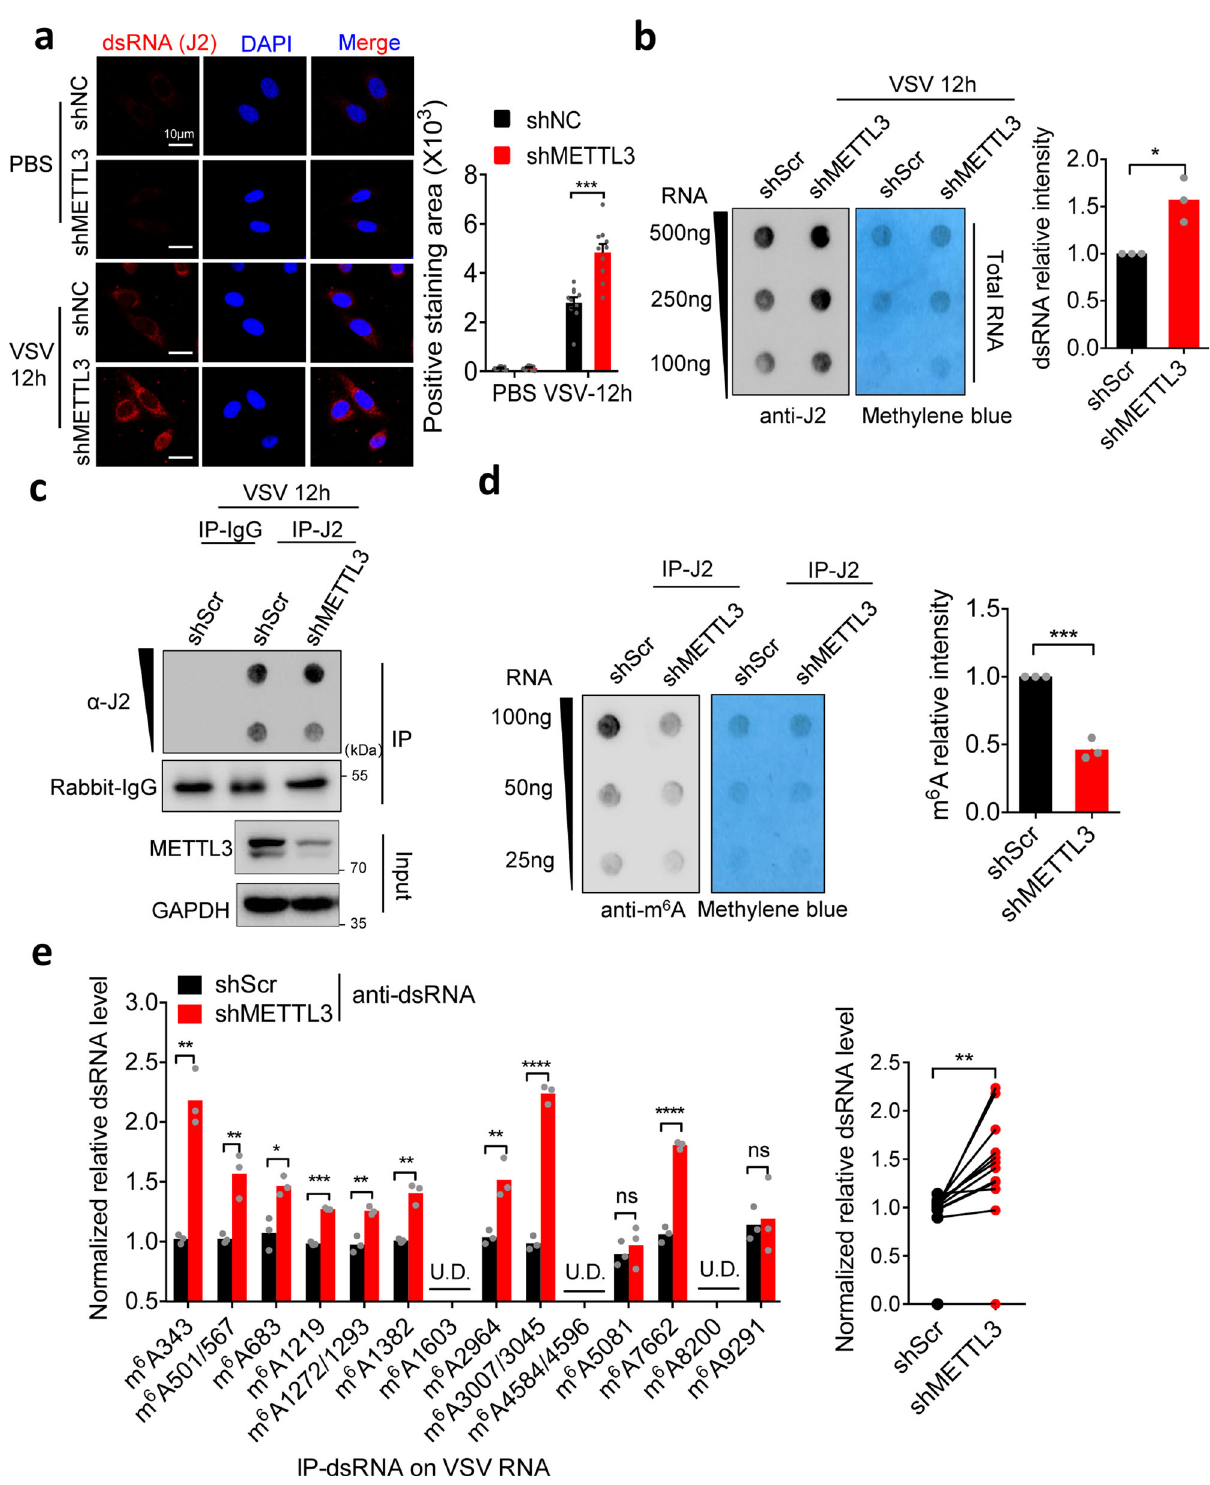
Fig. 5 METTL3-mediated m 6 A modi fi cation reshapes viral dsRNA. a Immuno fl uorescent analysis of dsRNA level after PBS treatment or VSV infection for 12 h in shNC and shMETTL3 HeLa cells. n = 10 cells examined over 2 independent experiments. b Dot blot analysis of dsRNA level after VSV infection for 12 h in HeLa cell. Methylene blue staining indicates equal RNA loading. The bar graph shows the statistics (right). n = 3 independent experiments. c , d Immunoblot ( c ) and dot blot ( d ) shows the immunoprecipitated (IP)-IgG or IP-dsRNA, and the m 6 A level in the IP-dsRNA in shScr and shMETTL3 HeLa cells. Methylene blue staining indicates equal RNA loading. The bar graph shows the statistics (right). e Anti-dsRNA-RIP-qPCR analysis of the dsRNA level in VSV RNA in shScr and shMETTL3 HeLa cells. The bar graph (Right panel) shows the statistics from the mean value of each m 6 A site (Left panel). Data are representative of 2 independent experiments. * p < 0.05, ** p < 0.01, *** p < 0.001, **** p < 0.0001 as determined by two-tailed unpaired Student ’ s t test ( a , b , d , e -left) or two-tailed paired Student ’ s t test ( e -right). Error bars represent mean ±